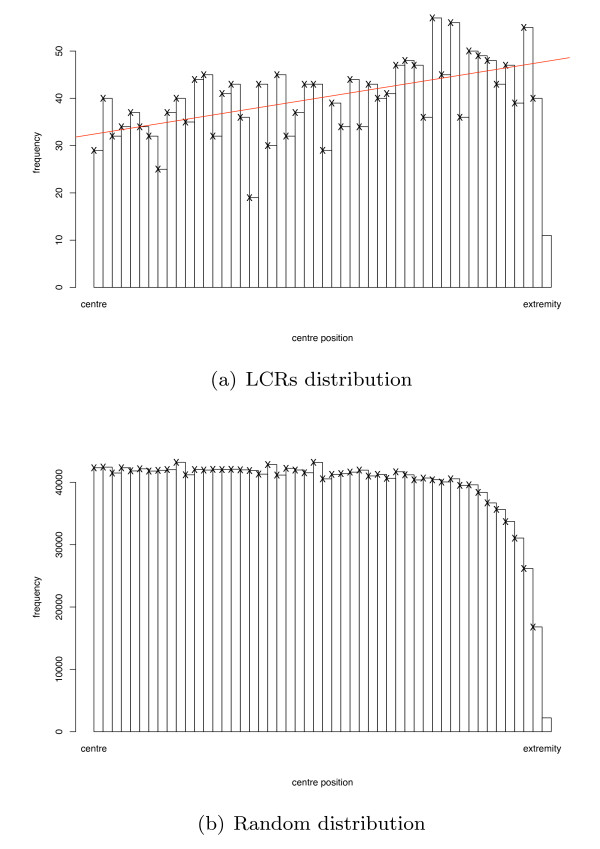
Distribution of folded LCR centre positions. Comparison of normalised and randomly re-arranged LCR centre positions in S. cerevisiae. The Kolmogorov-Smirnov test confirms that these two distributions are significantly different (p-value = 7.6 × 10-6).